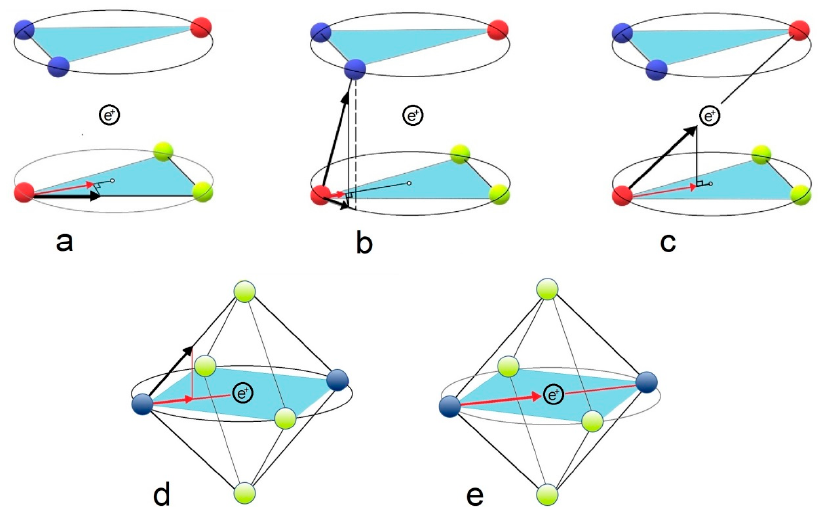
Figure 4. Centripetal force components (marked by red arrows) of the forces F 1 and F 2 for the equatorial ( a – c ) and top–bottom ( d , e ) neutrino rotations, respectively. Equatorial forces: √ √ √ 1 F 1 = 2F a + 2F b + F c ; F a = ( 1/2 3 )( Gm 2 /r 2 ) ; F b = ( 1/6 3 )( Gm 2 /r 2 ) ; F c = ( 1/3 6 )( Gm 2 /r 2 ) . √ . Top–bottom forces: F 2 = 4F d + F e ; F d = ( 2/6 )( Gm 2 /r 2 ) ; F e = ( 1/6 )( Gm 2 /r 2 ) .